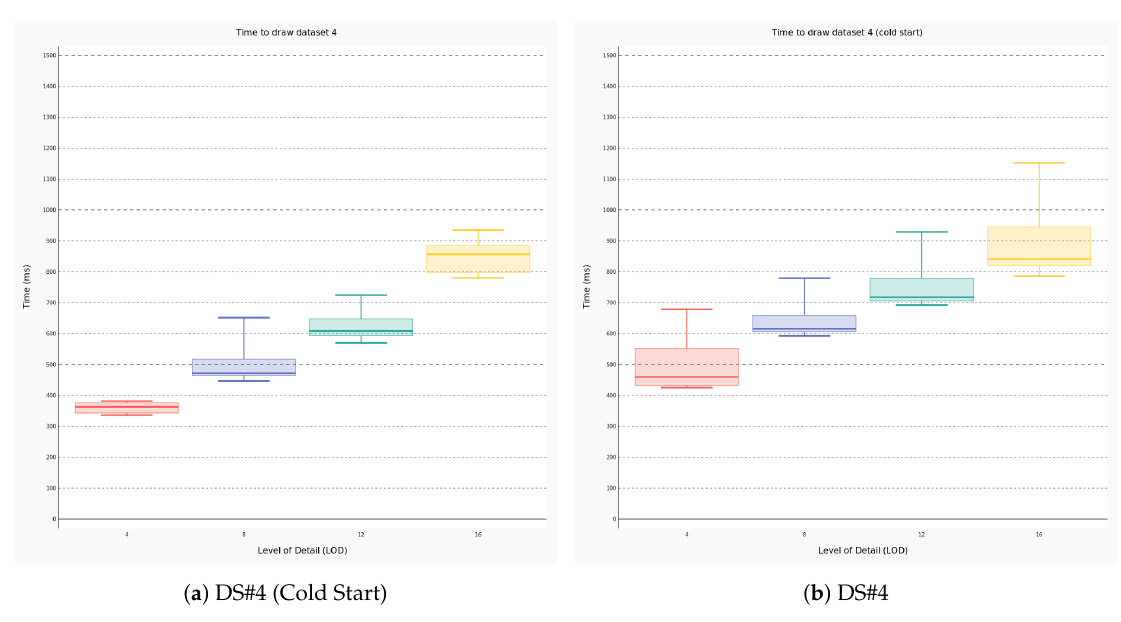
Figure 21. Time to represent